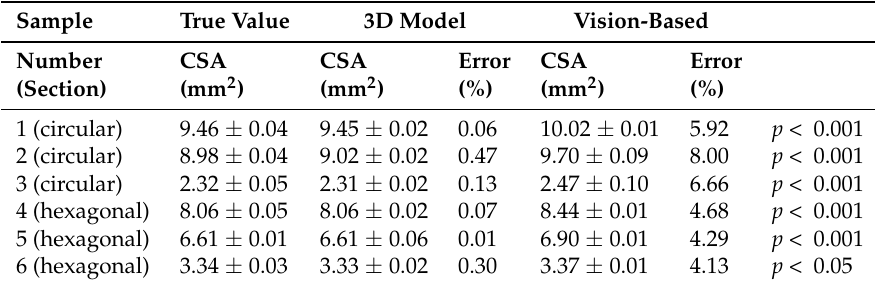
Table 1. The results of cross-sectional area (CSA) measurements of the regular styrene acrylonitrile resin (SAN) samples and corresponding relative errors using our 3D scanning system and vision-based method. Number of repeated measurements per sample n = 6. Data concerning CSA are presented as means with standard deviations. Differences were considered statistically significant for p < 0.05.